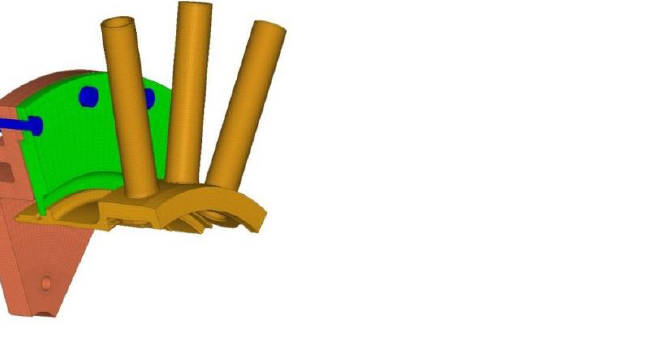
Figure 8. FE model of the vortex reducer and connecting structure under the test condition (1/6 sector).